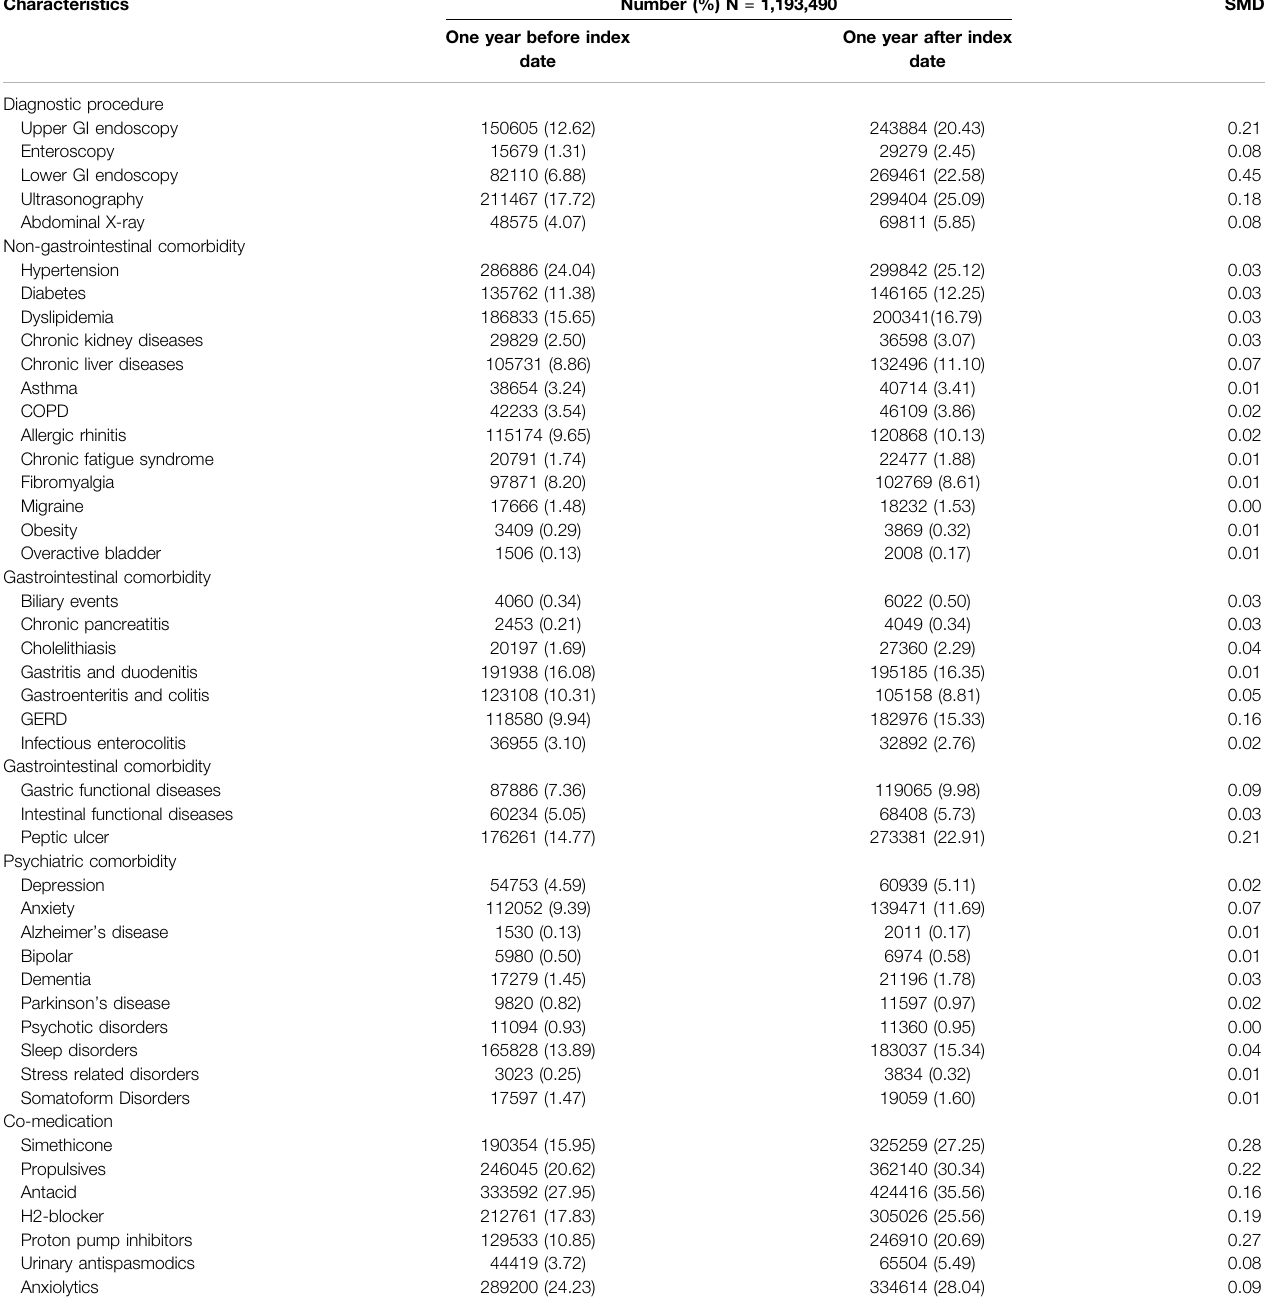
TABLE 2 | Diagnostic procedure, comorbidity, and comedication of irritable bowel syndrome population in Taiwan.